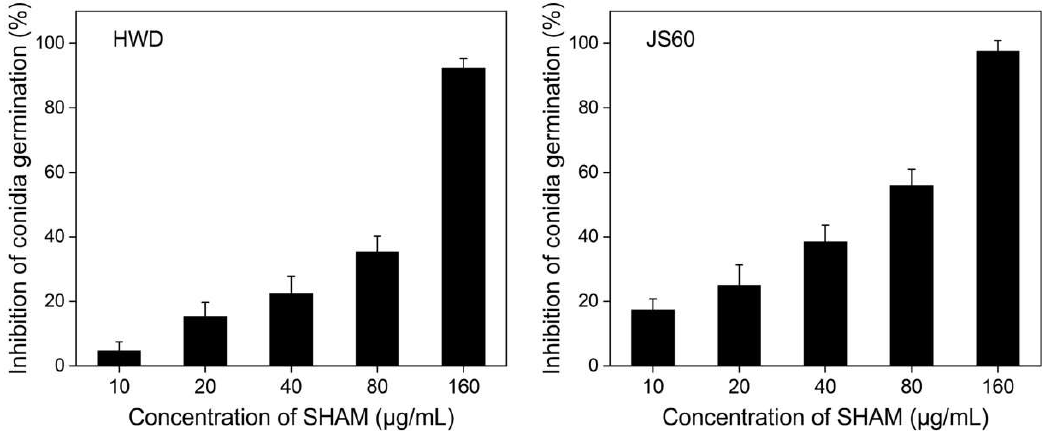
Figure 3. Inhibition of the conidial germination of Ustilaginoidea virens isolates HWD and JS60 by SHAM on water agar (WA). Error bars represent standard errors of the mean of three independent repetitions.